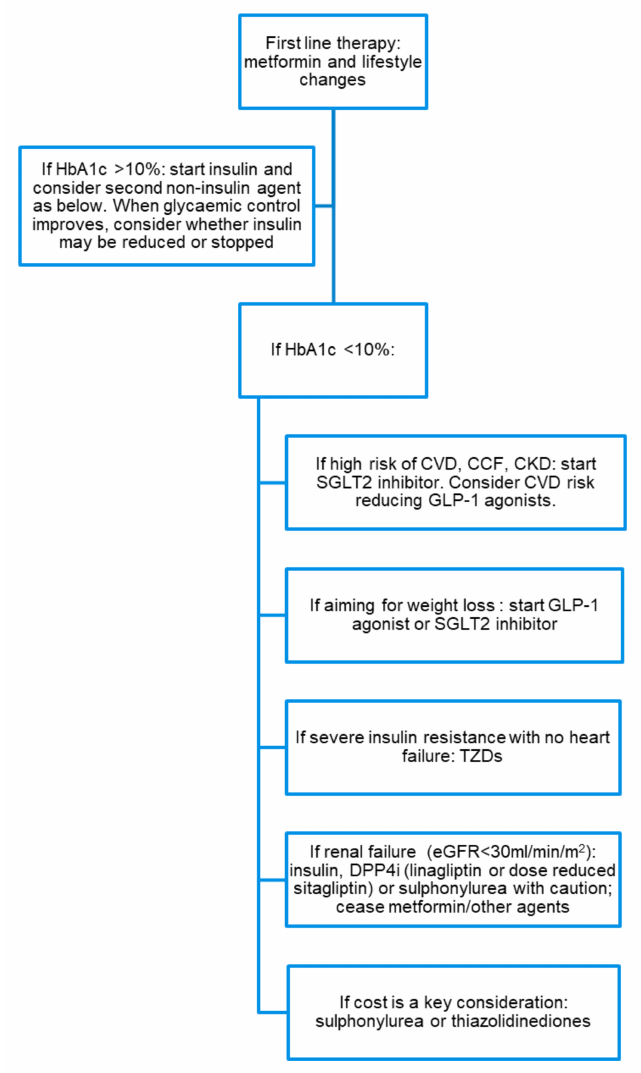
Figure 3. A flow diagram demonstrating a suggested approach to glucose-lowering therapies for type 2 diabetes (T2D). CVD: cardiovascular disease, CCF: congestive cardiac failure, CKD: chronic kidney disease, TZDs: thiazolidinediones, eGFR: estimated glomerular filtration